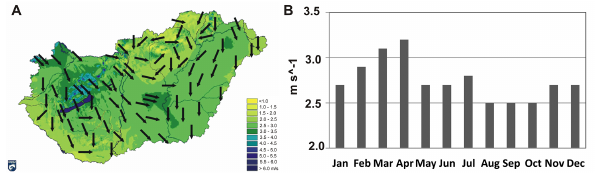
Table 1. Data sources for estimating regional wind erosion